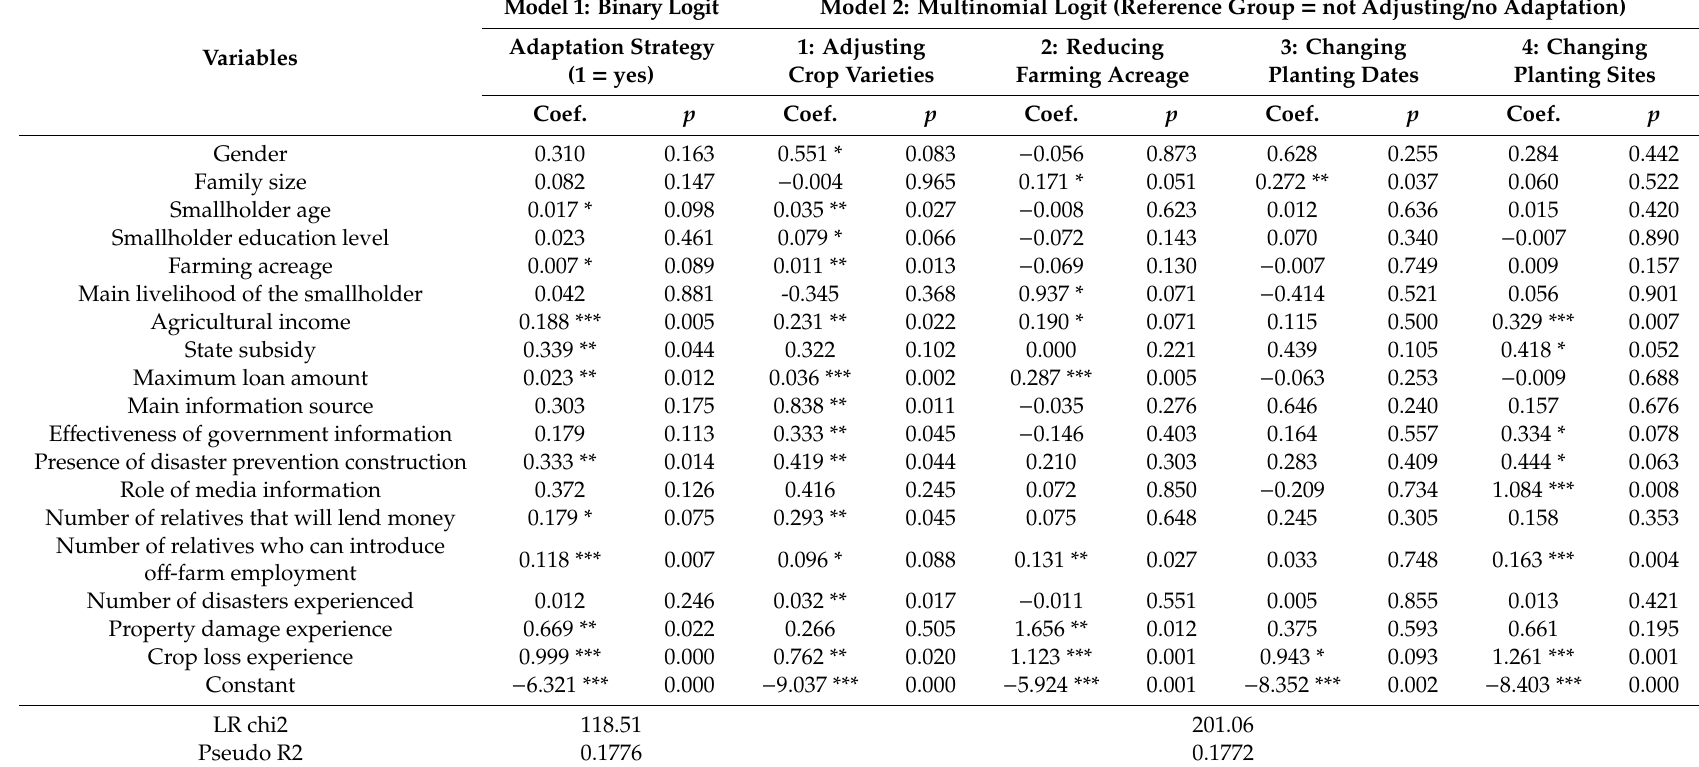
Table 2. Parameters estimation results on the determinants of adaptation